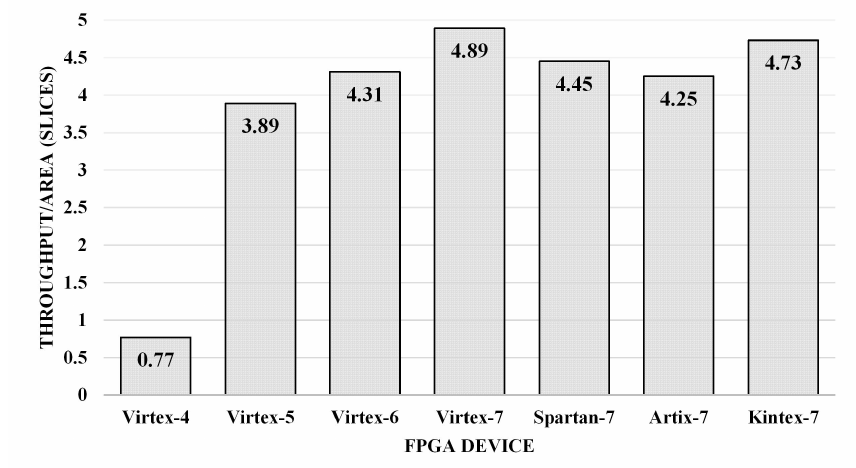
Figure 4. Throughput over area results (we used FPGA slices as areas for the calculation).